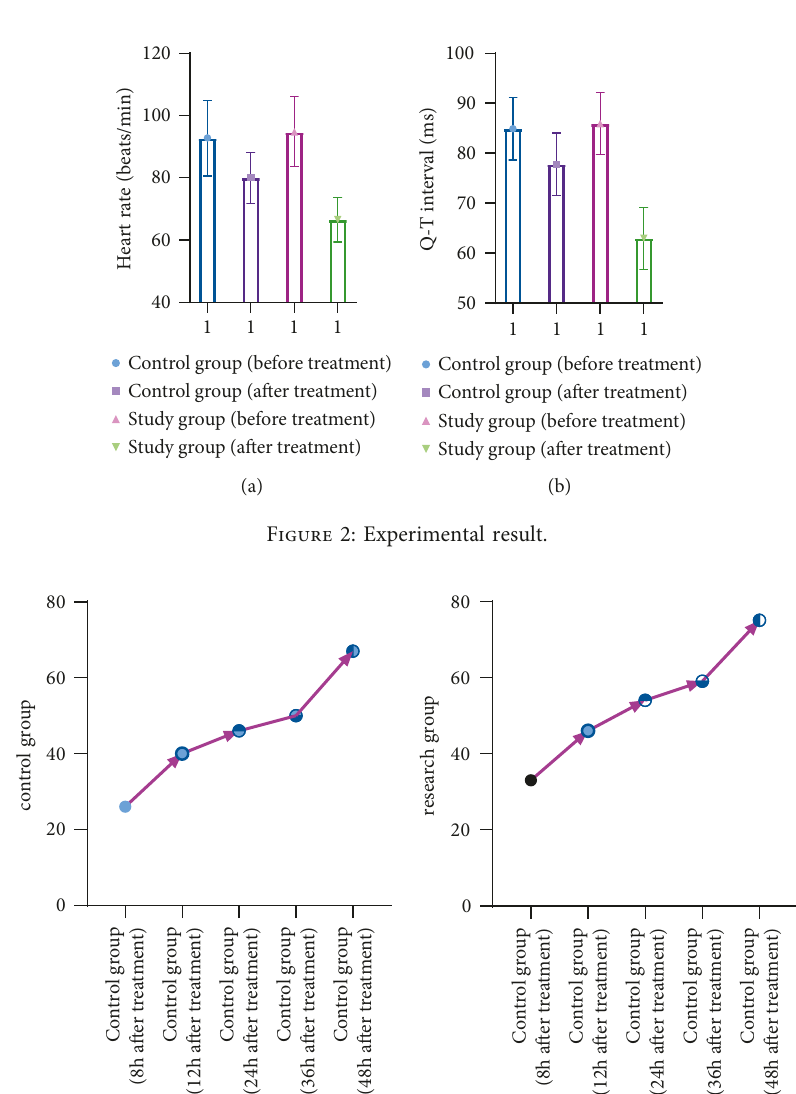
Figure 1: Experimental result.